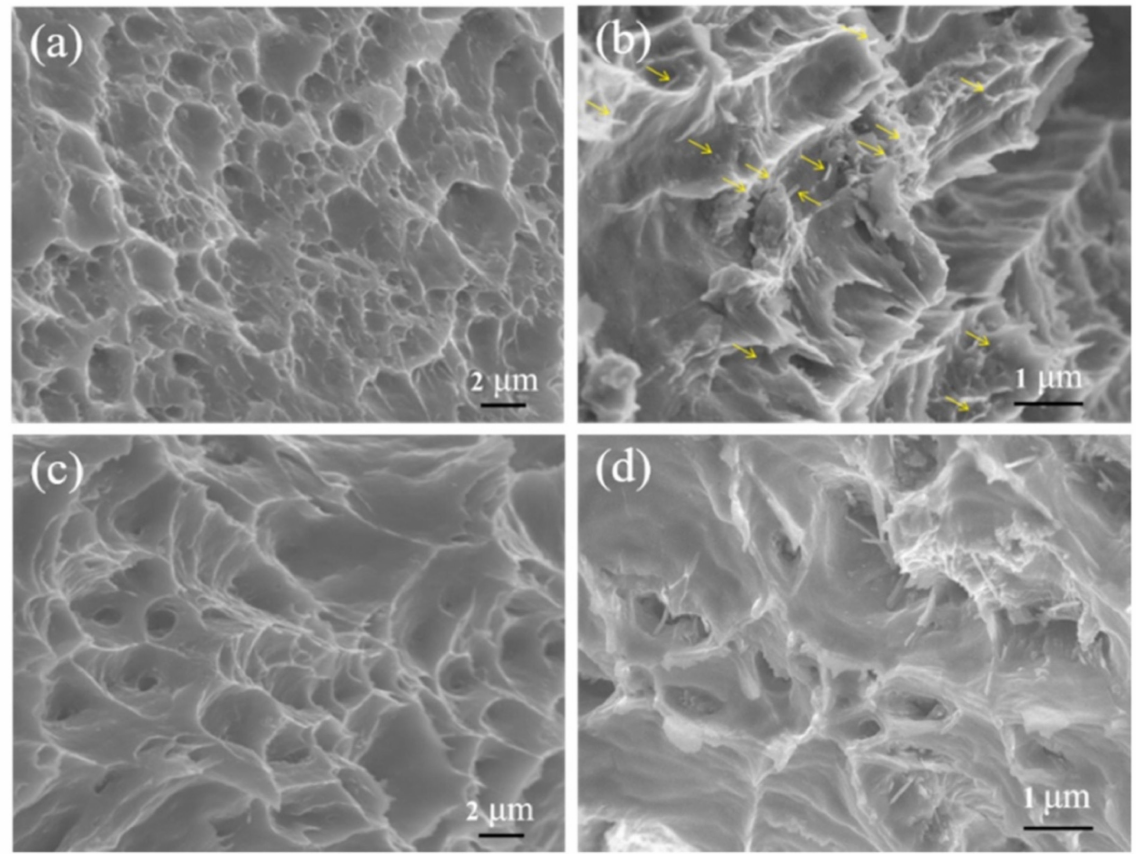
Figure 5. SEM images of the surface fracture of Al/CNT nanocomposites produced with ( a ) 0.5 and ( b ) 1.0 wt.% of large-aspect ratio CNTs and ( c ) 0.5 and ( d ) 1.0 wt.% of small-aspect ratio CNTs. Reproduced from [72] with permission from Elsevier,